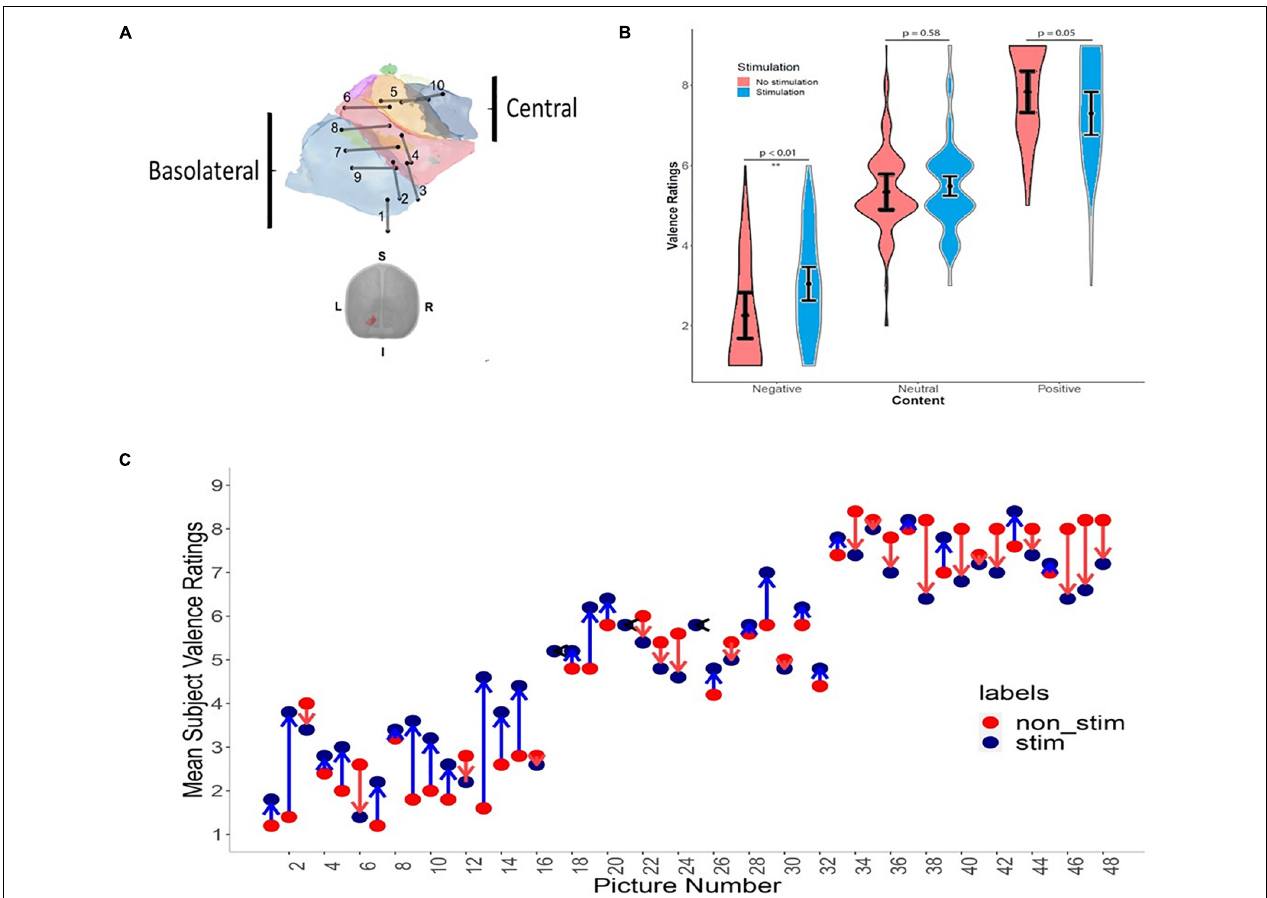
FIGURE 3 | The effect of amygdala stimulation on perception of valence. (A) The location of left amygdala electrode contacts for 10 patients. (B) Violin plot showing average valence rating across 10 patients for all 48 images separated by valence categories and stimulation status (neutral used IAPS value 4.1–6.0, positive 6.1–8.0, and negative 2.0–4.0). (C) Mean subject valence ratings across all patients for all images for unstimulated and stimulated trials. X-axis represents images 1–48 arranged in order of their original IAPS valence score from negative on the left to positive on the right. The y-axis shows mean patient-reported valence judgments ranging from one (negative) to nine (positive) for both non-stimulated (red) and stimulated (blue) trials. The arrows represent the average direction and magnitude of change between the unstimulated and stimulated trials. Blue arrow represents an increase in mean valence (i.e., more positive) with stimulation, red arrow represents a decrease in mean valence (more negative) with stimulation, and black arrow represents no change in mean valence with stimulation. TABLE 2 | The effect of stimulation of the left amygdala on valence judgments for negative, neutral, and positive images. Estimate Lower 95% CI Upper 95% CI p value Degree of freedom Negative valence 0 . 79 0 . 24 1 .